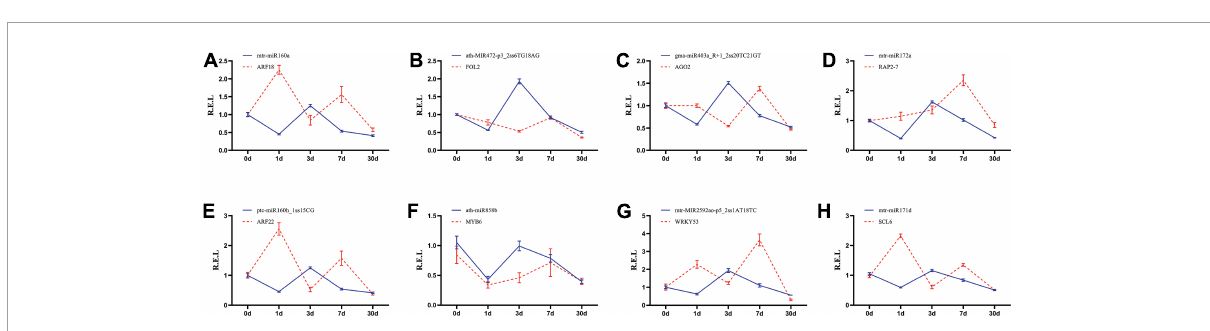
FIGURE6 Expression correlation between miRNAs and their targets at five different Pi treatment durations. (A) mtr-miR160a / ARF18 ; (B) athMIR472p3_2ss6TG18AG / FOL2 ; (C) gmamiR403a_R + 1_2ss20TC21GT / AGO2 ; (D) mtr-miR172a/RAP2-7; (E) ptc-miR160h_1ss15CG/ARF22; (F) ath-miR858b / MYB6 ; (G) mtr-MIR2592ao-p5_2ss1AT18TC / WRKY53 ; (H) mtr-miR171d / SCL6 ; The blue and red lines indicate miRNAs and the target abundance, respectively, based on the RT-qPCR